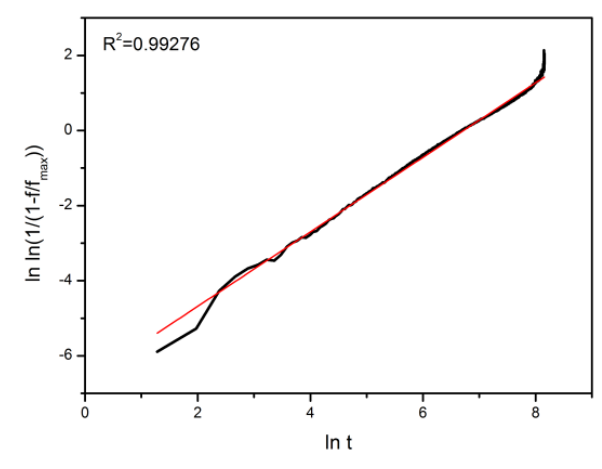
Figure 8. Fitting curve lnt — ln ln ( 1/ ( 1 − f / f max )) diagram.